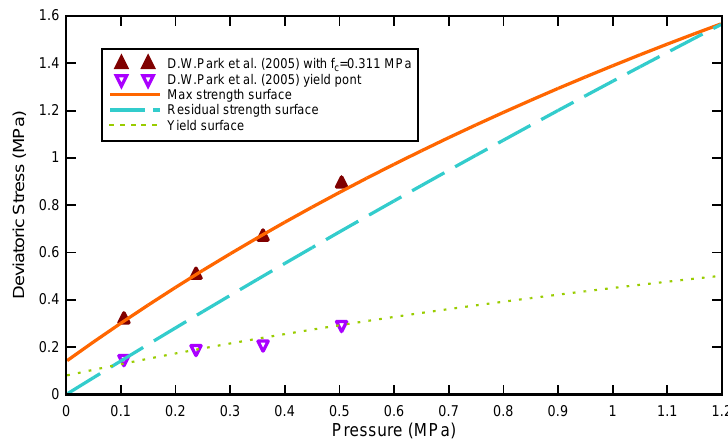
Figure 2. Determination of parameters in KCC from experimental data.